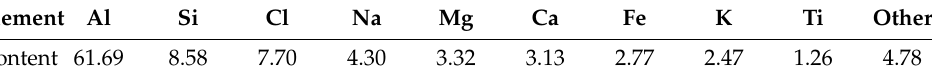
Table 1. XRF analysis results of original aluminum dross (Unit: wt%).